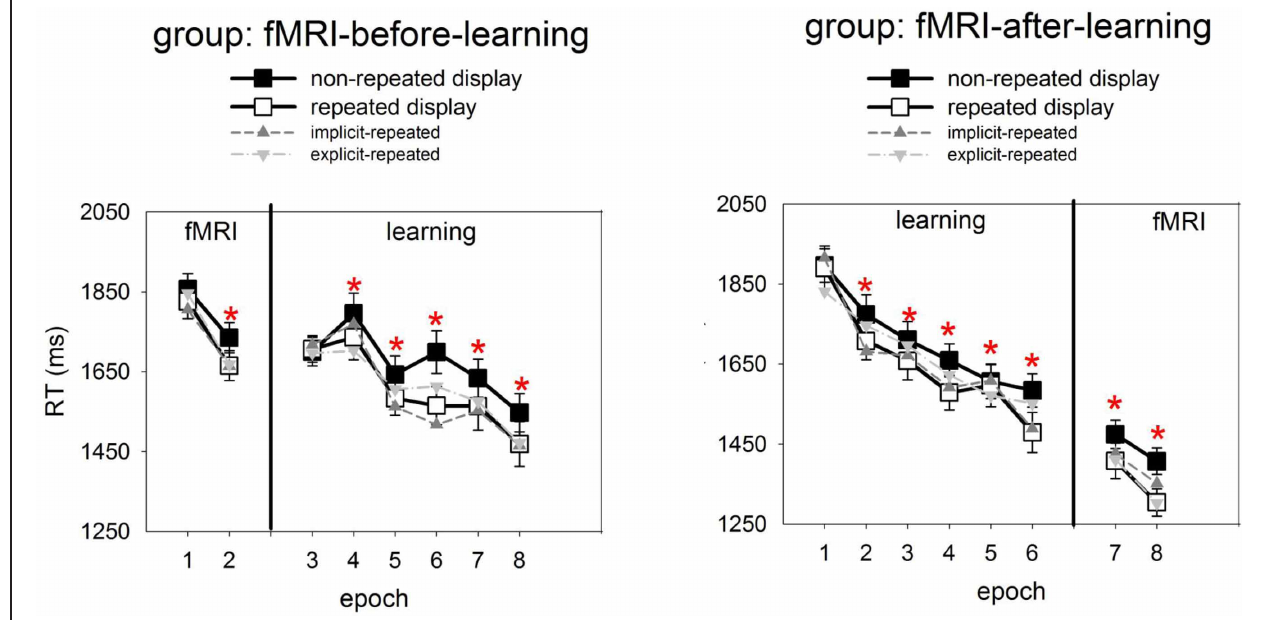
(comprising of 2 epochs) and learning sessions (6 epochs). Significant RT differences between repeated and non-repeated displays (i.e., contextual cueing) are marked by red asterisks. Also shown are RTs to implicit- and explicit-repeated displays (dark and light grey triangles, respectively).